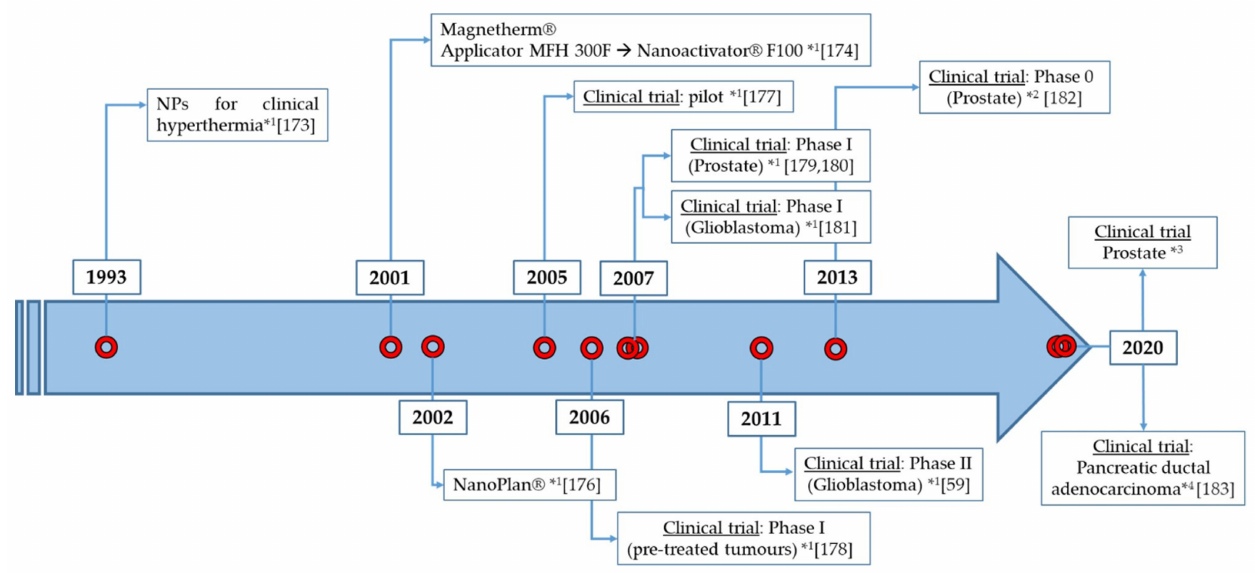
Figure 4. Timeline of the major milestones and clinical trials carried out on humans where Magnetic Hyperthermia Treatment was